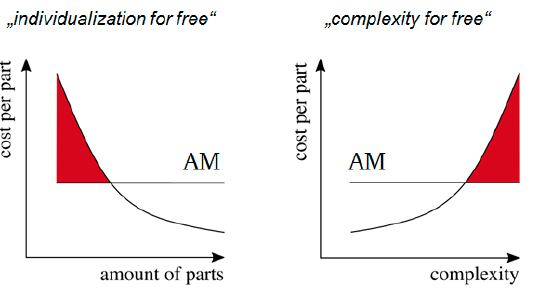
Figure 1. Advantages of additive manufacturing (horizontal lines) in terms of industrial application as compared to conventional manufacturing (reference curves) [5].